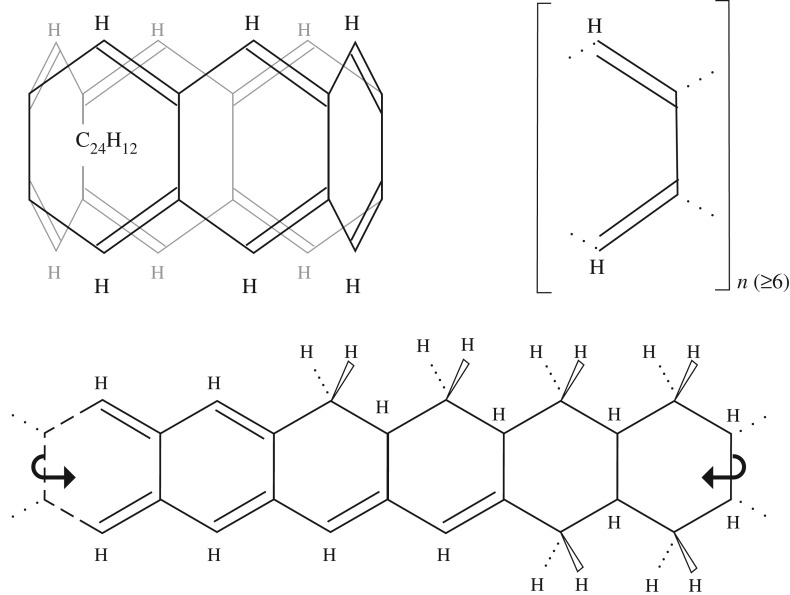
A proposed ‘ring of rings’ family of molecules: couronene, C24H12 (S6, upper left), the structure for a concatenated cycle of aromatic rings with generic formula (C4H2)n (Sn, upper right). If all the carbon atoms are sp3, then the aliphatic multi-ring structure is a couronane, C24H36, generically (C4H6)n, where n≥6. Mixed aliphatic/aromatic ring structures would then be courone-anes, with the generic formula (C4H2−6)n, where n≥6.